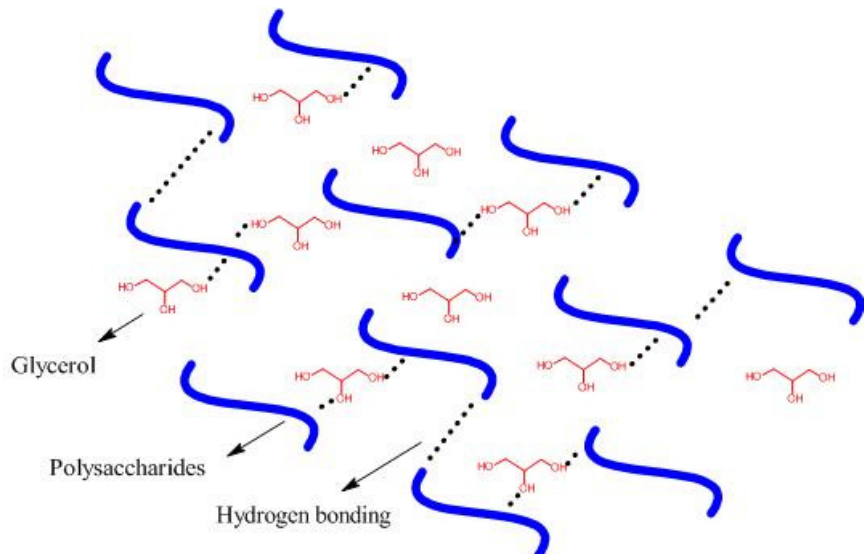
Figure 3. Polysaccharides and plasticizer interactions in the bioplastic matrix.